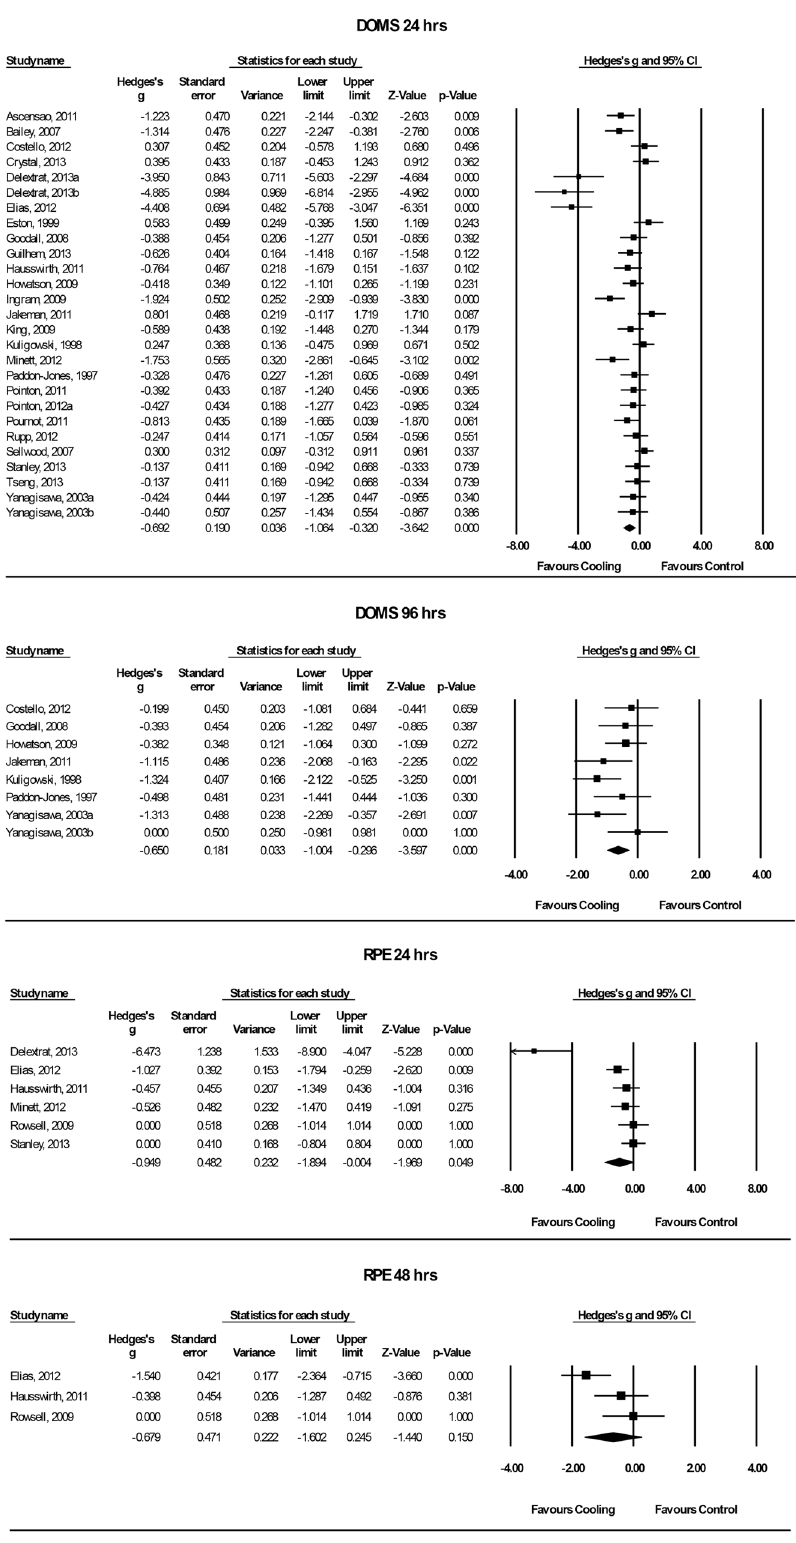
Fig 4. Forest plot of the meta-analysis illustrating the comparison of cooling versus control for measurement of DOMS AND RPE. DOMS = delayed-onset muscle soreness, RPE = ratings of perceived